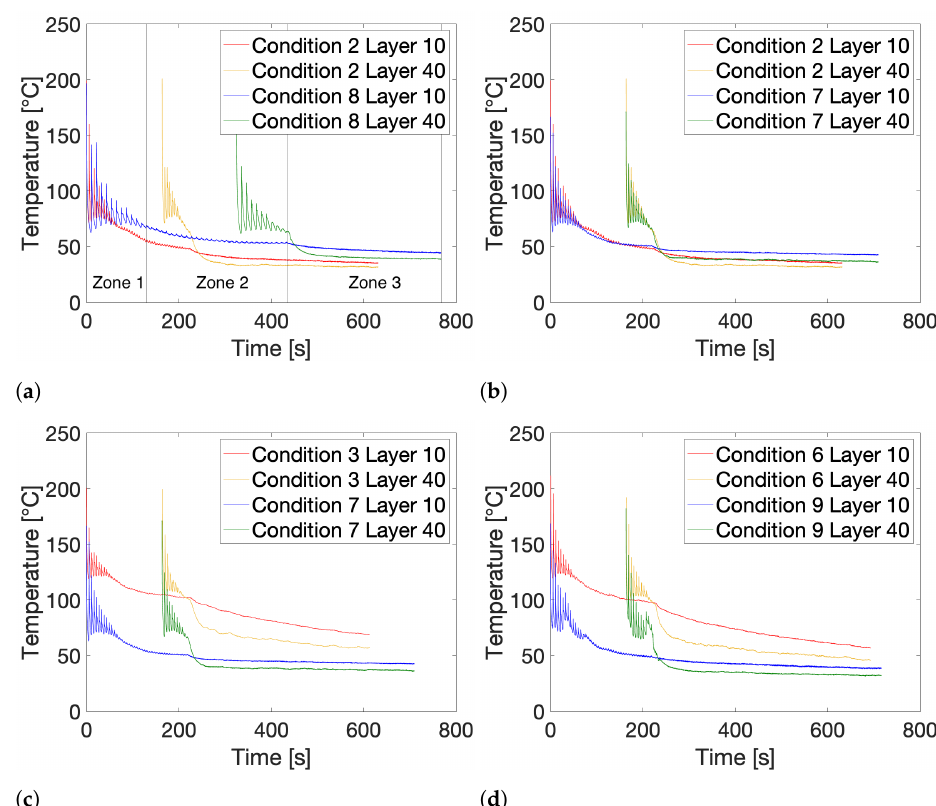
Figure 5. A comparison of the thermal history recorded through IR thermography of printing conditions 7 to 9 with T build plate of 40 °C with respect to their counterparts printed with a build plate temperature of 110 °C that is, printing conditions 2, 3, and 6. ( a ) Comparison between v print of 5.5 (Condition 8) and 11 mm/s (Condition 2) for T build plate = 40 °C. ( b ) Comparison between T liquefier of 260 (Condition 2) and 240 °C (Condition 7) for T build plate = 40 °C. ( c ) Comparison between T build plate of 40 (Condition 7) and 110 °C (Condition 3) for T liquefier = 240 °C. ( d ) Comparison between T build plate of 40 (Condition 9) and 110 °C (Condition 6) for LMWPA